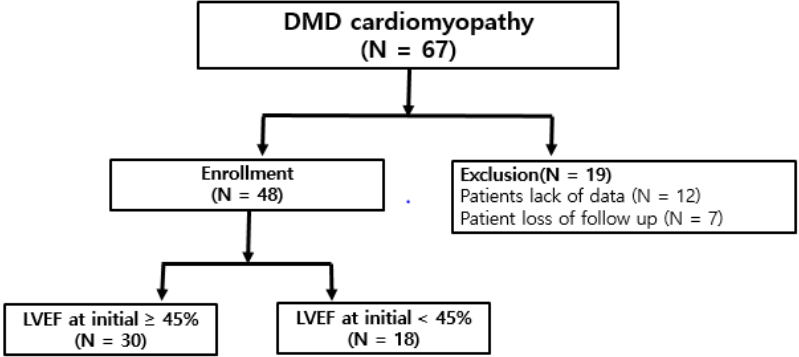
Figure 1. Sixty-seven DMD (Duchenne muscular dystrophy) cardiomyopathy patients’ data were collected. Nineteen patients were excluded due to the lack of data or loss of follow up. Forty-eight DMD patients were divided into 2 groups of left ventricle ejection fraction (LVEF) at initial treatment over 45% (Group 1) and under 45% (Group 2). N; number.